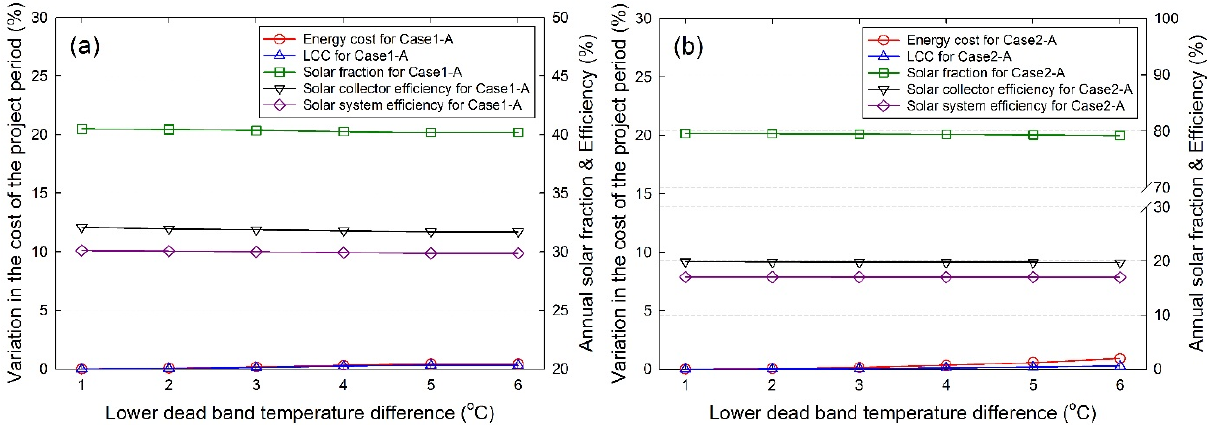
Figure 13. Effect of a difference in the temperature of the lower dead band of the differential temperature controller on the energy and economic performances of the SWH systems: ( a ) Case1-A and ( b )